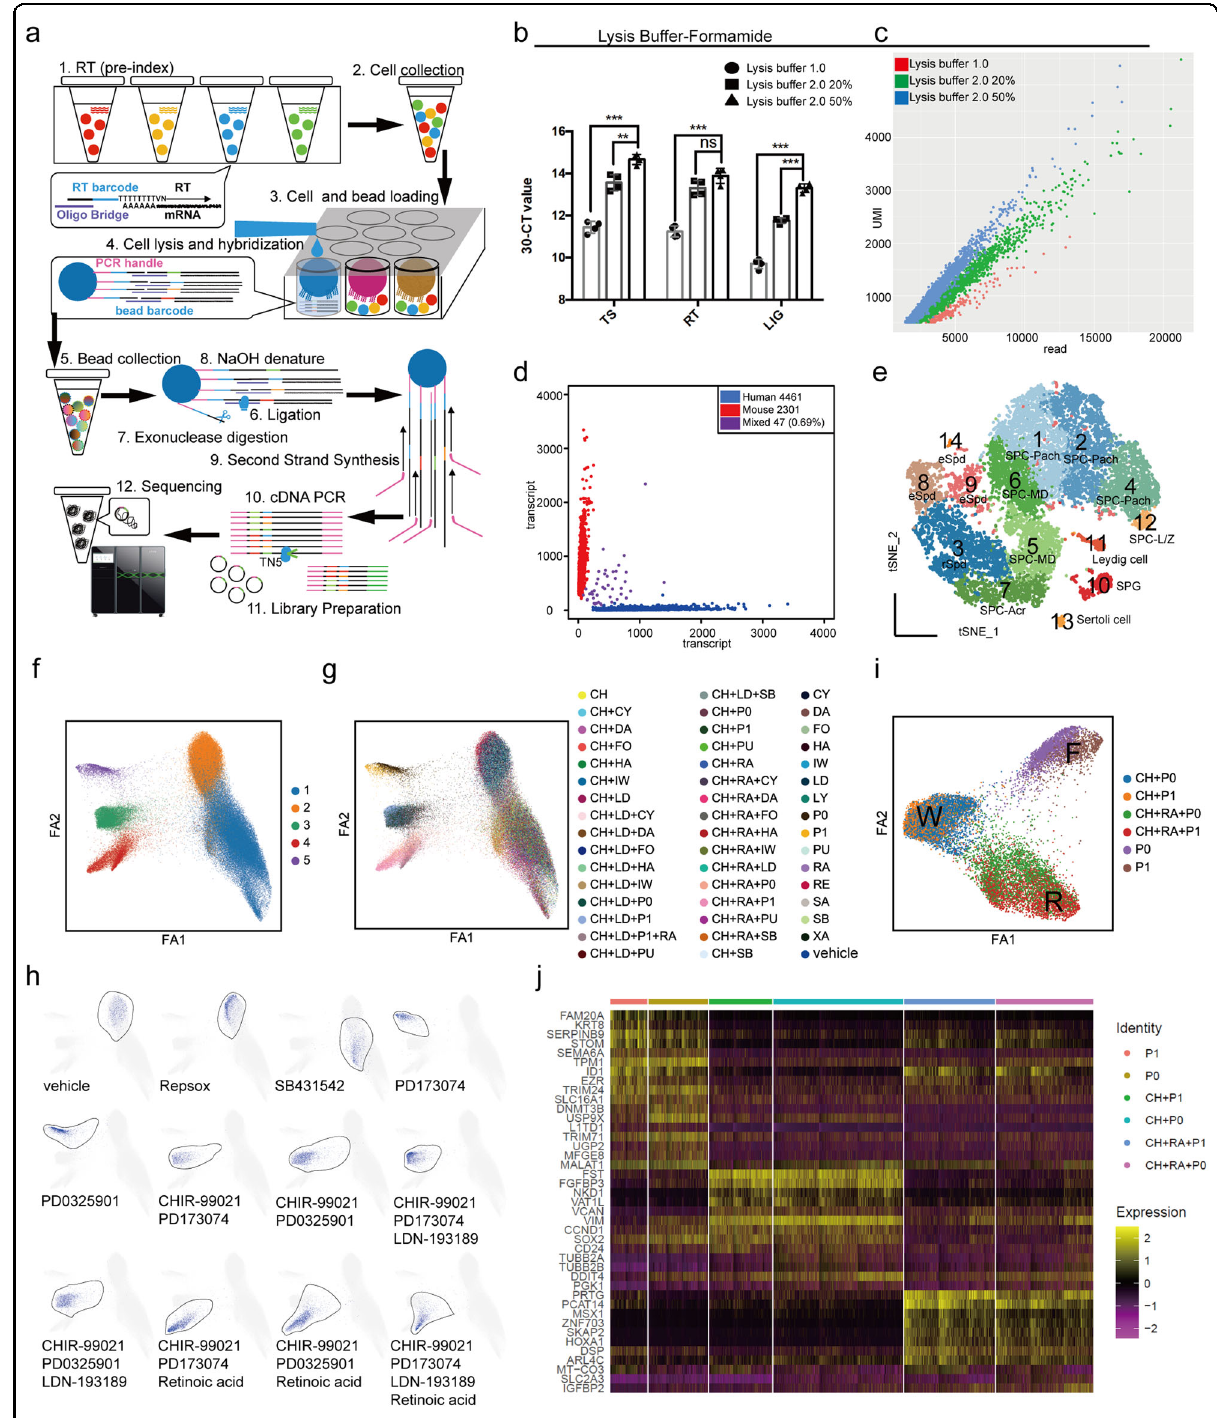
Fig. 1 (See legend on next